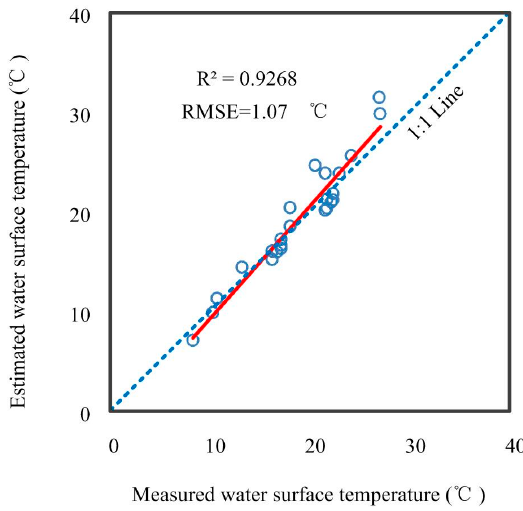
Figure 6. Plot of estimated water surface temperature versus measured water surface temperature.